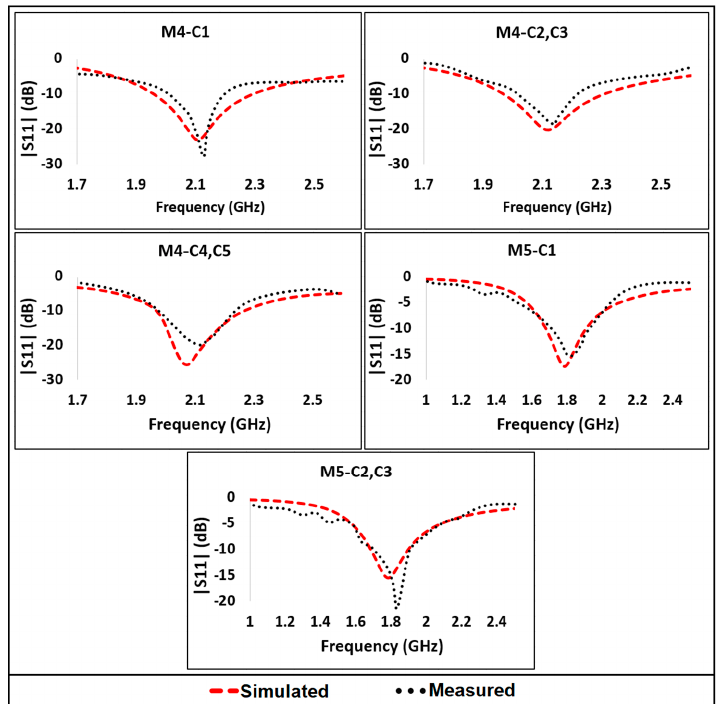
Electronics 2021 , 10 , x FOR PEER REVIEW Figure 9. Measured vs Simulated |S11| for Cases of Modes 4 and 5. Figure 9. Measured vs. Simulated |S11| for Cases of Modes 4 and 5.